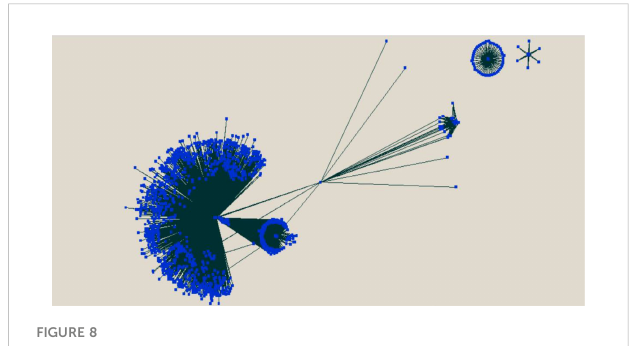
FIGURE 8 Visualization of the predicted protein – protein interaction between rice and M. grisea using the Cytoscape tool.